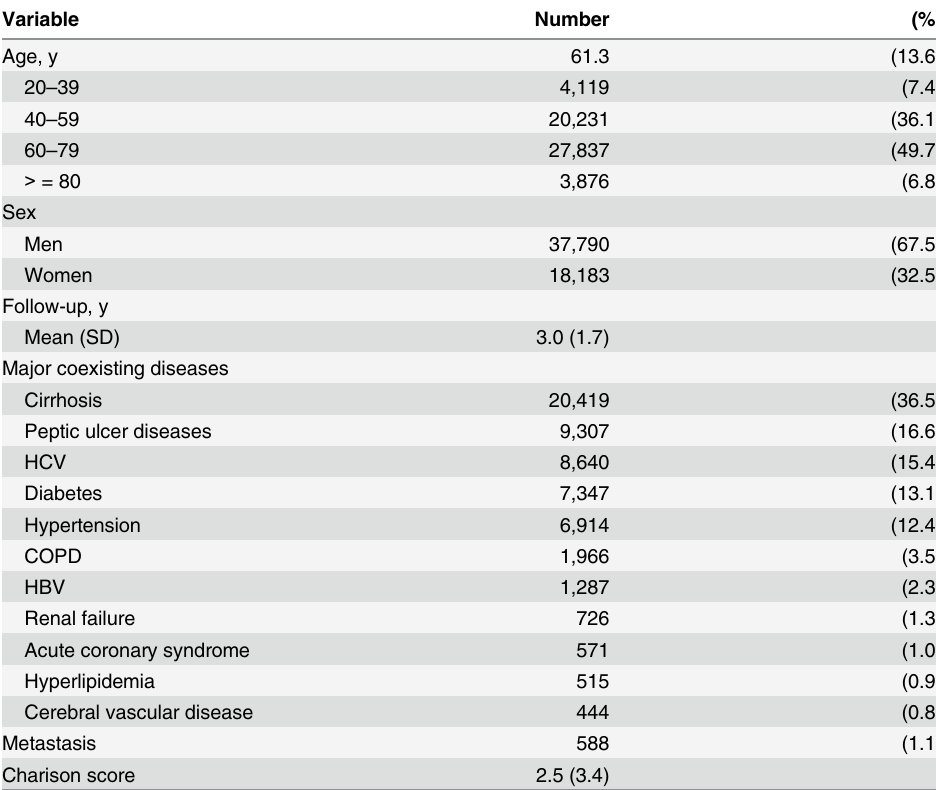
Table 1. Basic Profile of Patients with HCC (n =